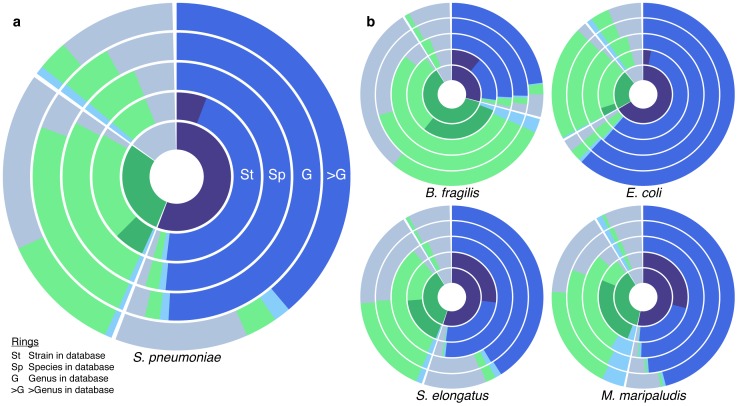
The impact of phylogenetic coverage of the database on the performance of a translated BLAST-based annotation.(a) The inner ring represents the proportion of the S. pneumonia genome annotated with KO genes, non-KO genes, and intergenic regions, as in Figure 1. Outer Rings illustrate the annotations for reads from each such category obtained with varying levels of phylogenetic coverage, ranging from having the strain from which the reads originated present in the database, to having only other genomes from the same species, genus, or higher taxonomic levels present. (b) The impact of phylogenetic database coverage on the annotation of B. fragilis, E. coli, S. elongatus, and M. maripaludis genomes.